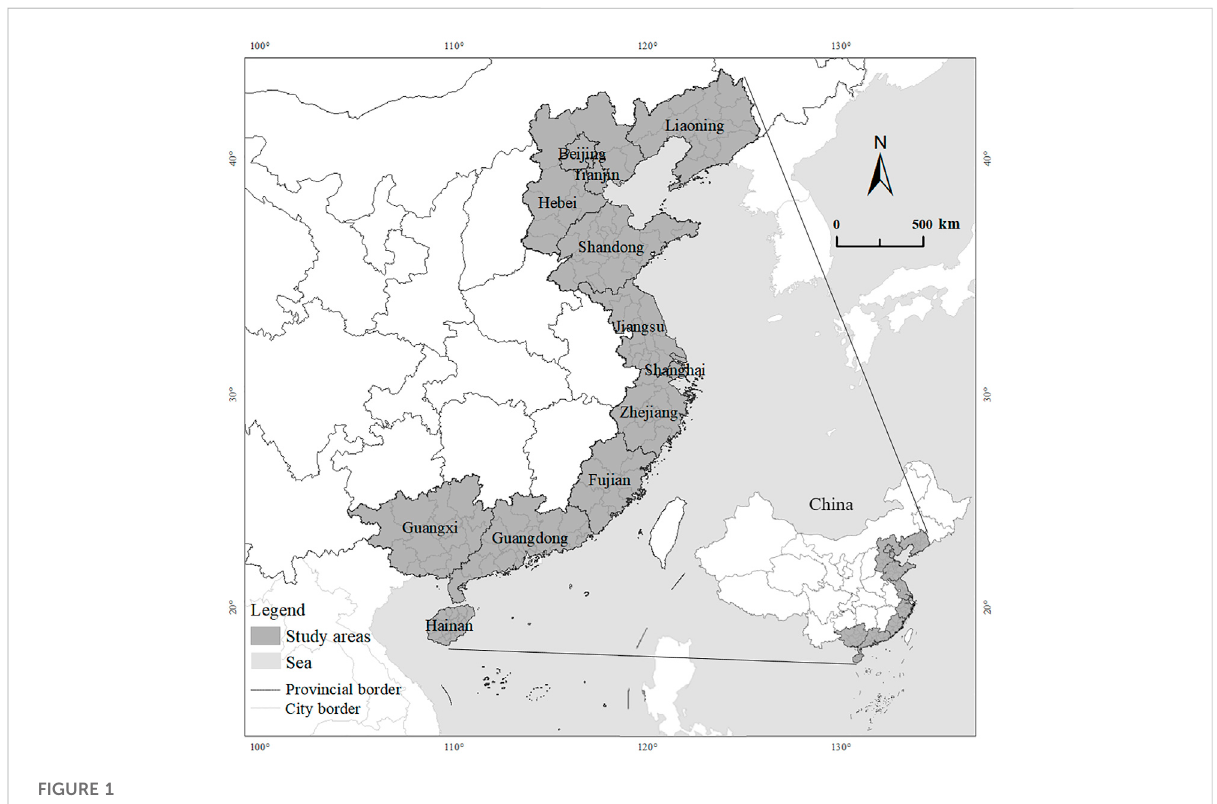
FIGURE 1 The location of study